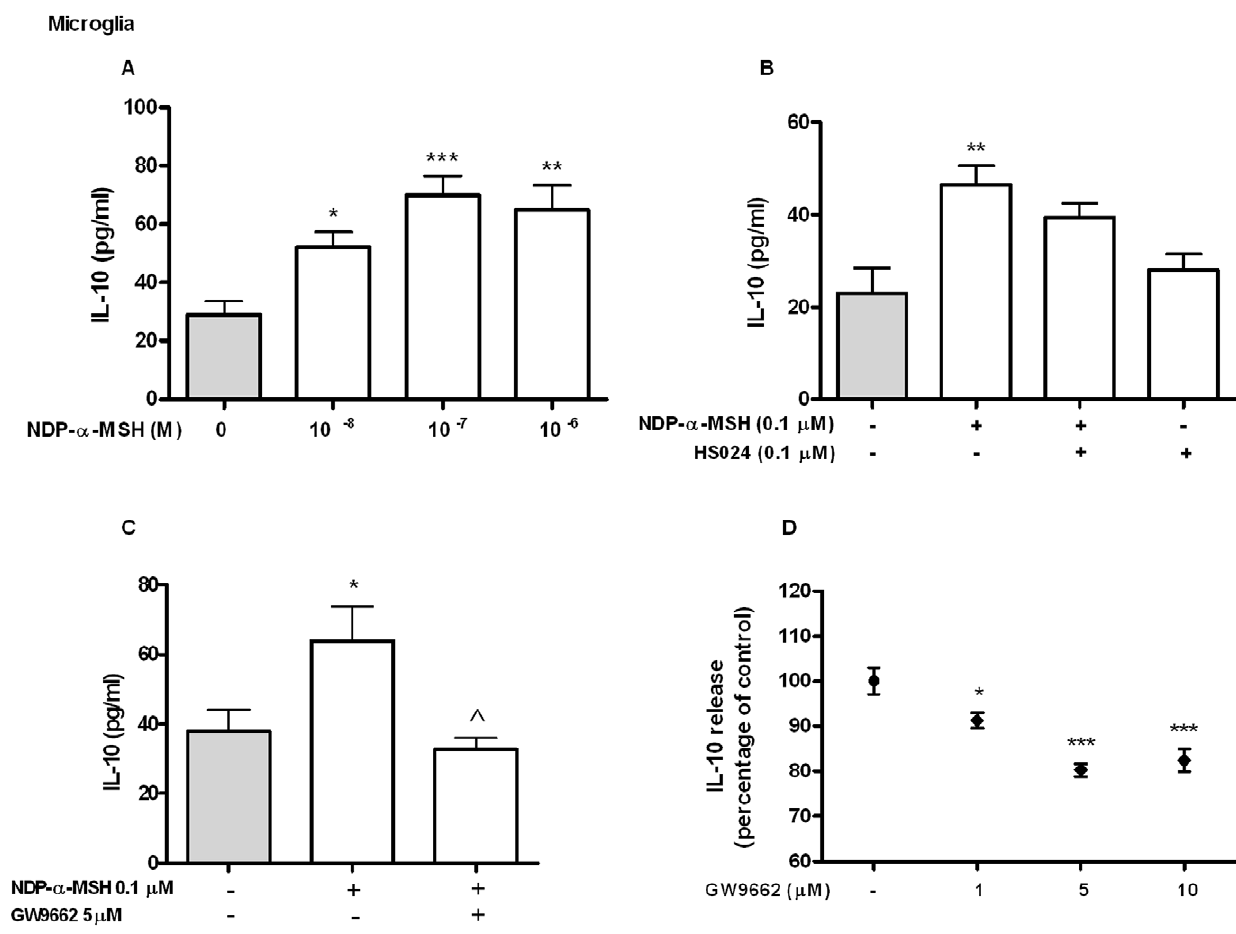
Figure 5. IL-10 release from rat microglia. IL-10 levels in culture supernatants were quantified by ELISA after 24 h of treatment. (A) NDP- a -MSH induced IL-10 release from microglial cells. The stimulatory effect of NDP- a -MSH is not seen in the presence of the MC4R antagonist HS024 (B) or of the PPAR- c antagonist GW9662 (C). (D) GW9662 has an inhibitory effect per se on IL-10 release from microglia. Data were analyzed by one way ANOVA followed by Dunnett’s or Bonferroni’s post test and are expressed as mean 6 SEM. *** p , 0.001, ** p , 0.01, * p , 0.05 vs. control group, ‘ p , 0.05 vs. NDP- a -MSH.